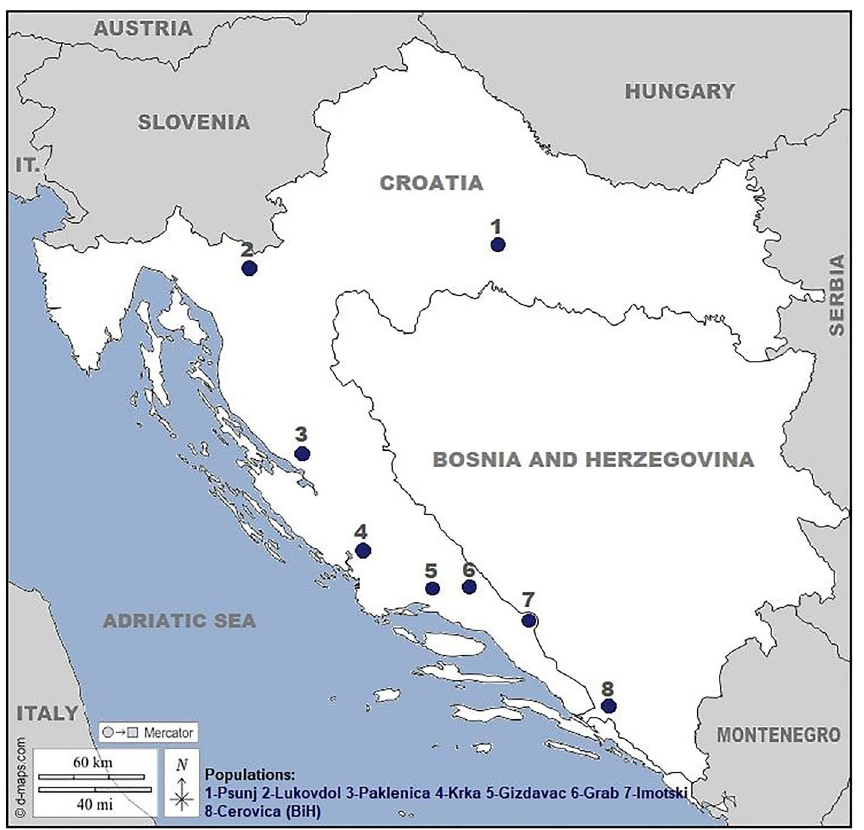
Figure 4. Map of seven in situ Croatian V. sylvestris populations and the Cerovica population in Bosnia and